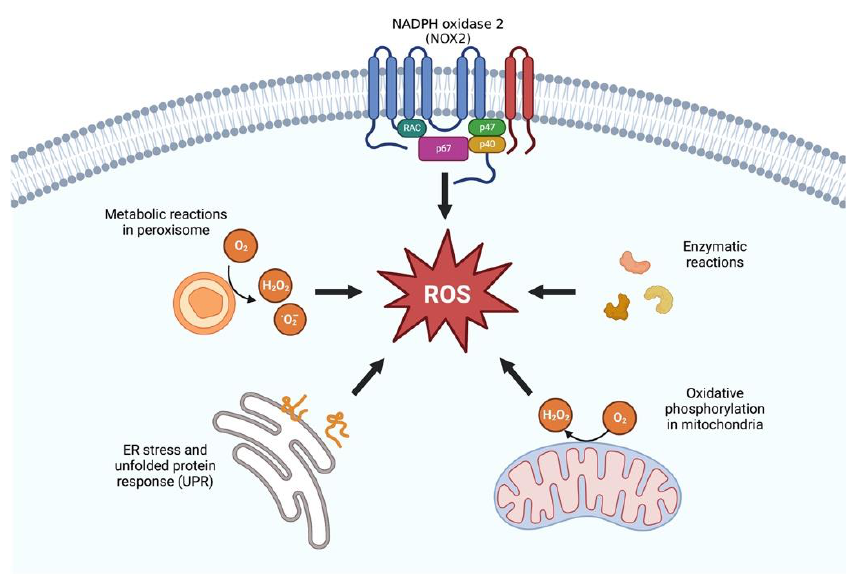
Figure 1. Endogenous reactive oxygen species (ROS) production. Intracellular ROS is primarily produced by the mitochondria, in which ROS are largely generated by the electron transport chain. Other sources of ROS include the transmembrane NADPH oxidases; xanthine oxidoreductase in peroxisomes; protein disulfide isomerase, which are involved in the unfolded protein response in the endoplasmic reticulum (ER); and diverse enzymatic reactions that, among others, include prostaglandin synthesis, auto-oxidation of adrenalin, and reduced riboflavin.